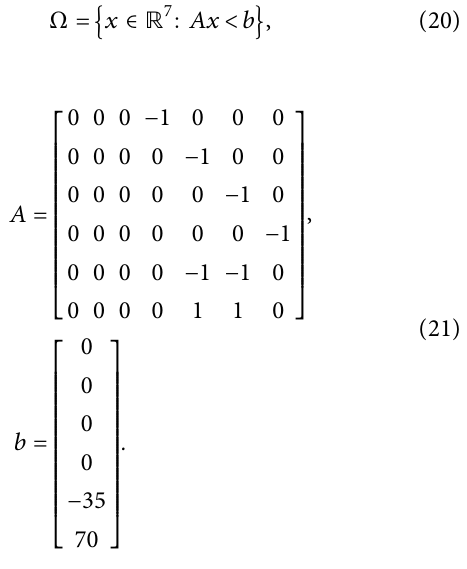
Figure 1: A geometric illustration of estimate projection diagram for constrained minimization of